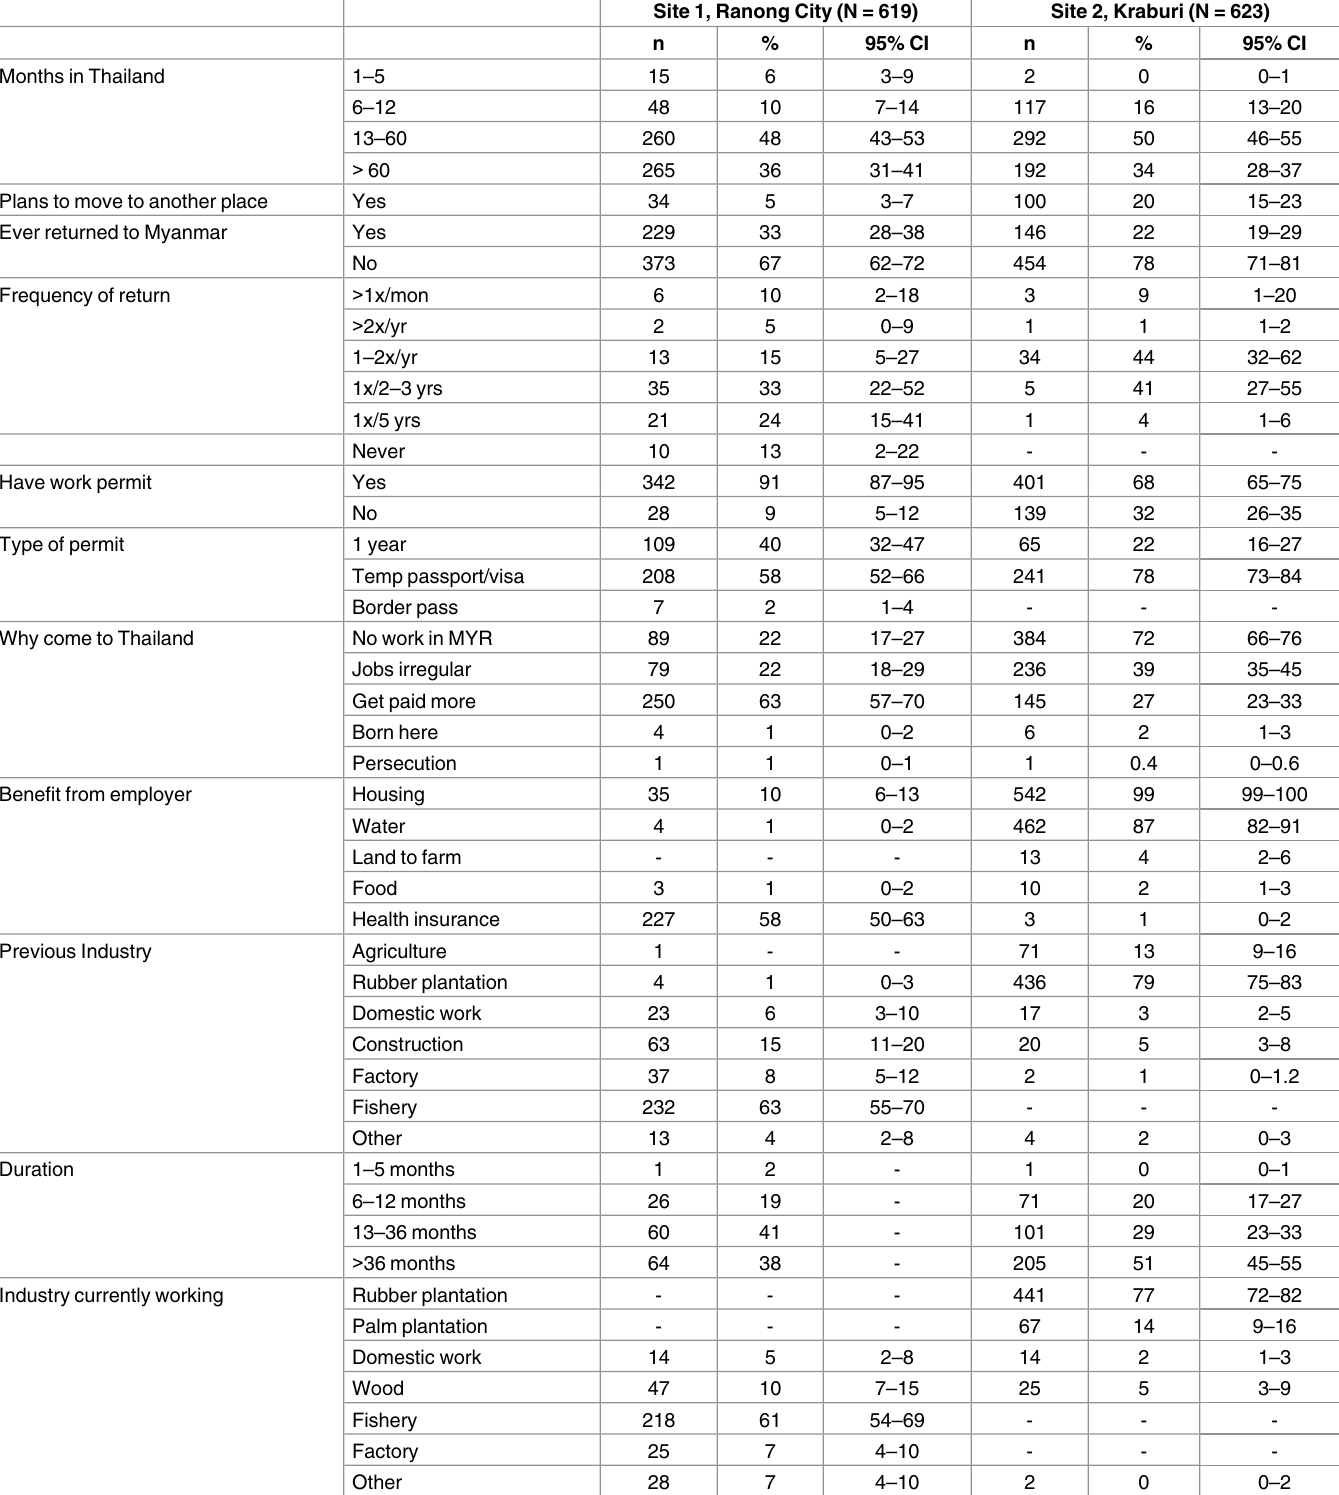
Table 2. RDS-weighted estimates of travel and occupational history by